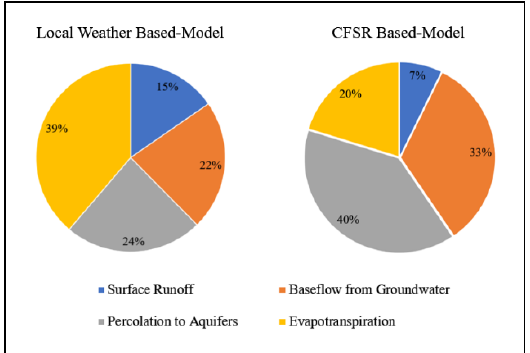
Figure 8. R 2 Values per year.